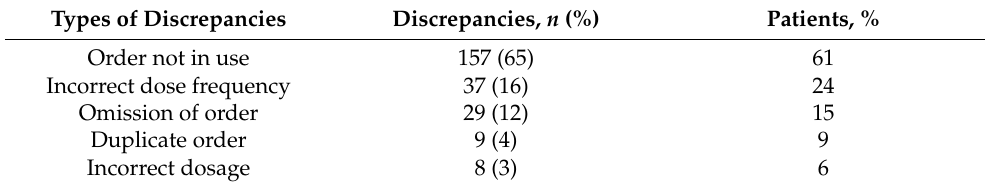
Table 2. Types and number of